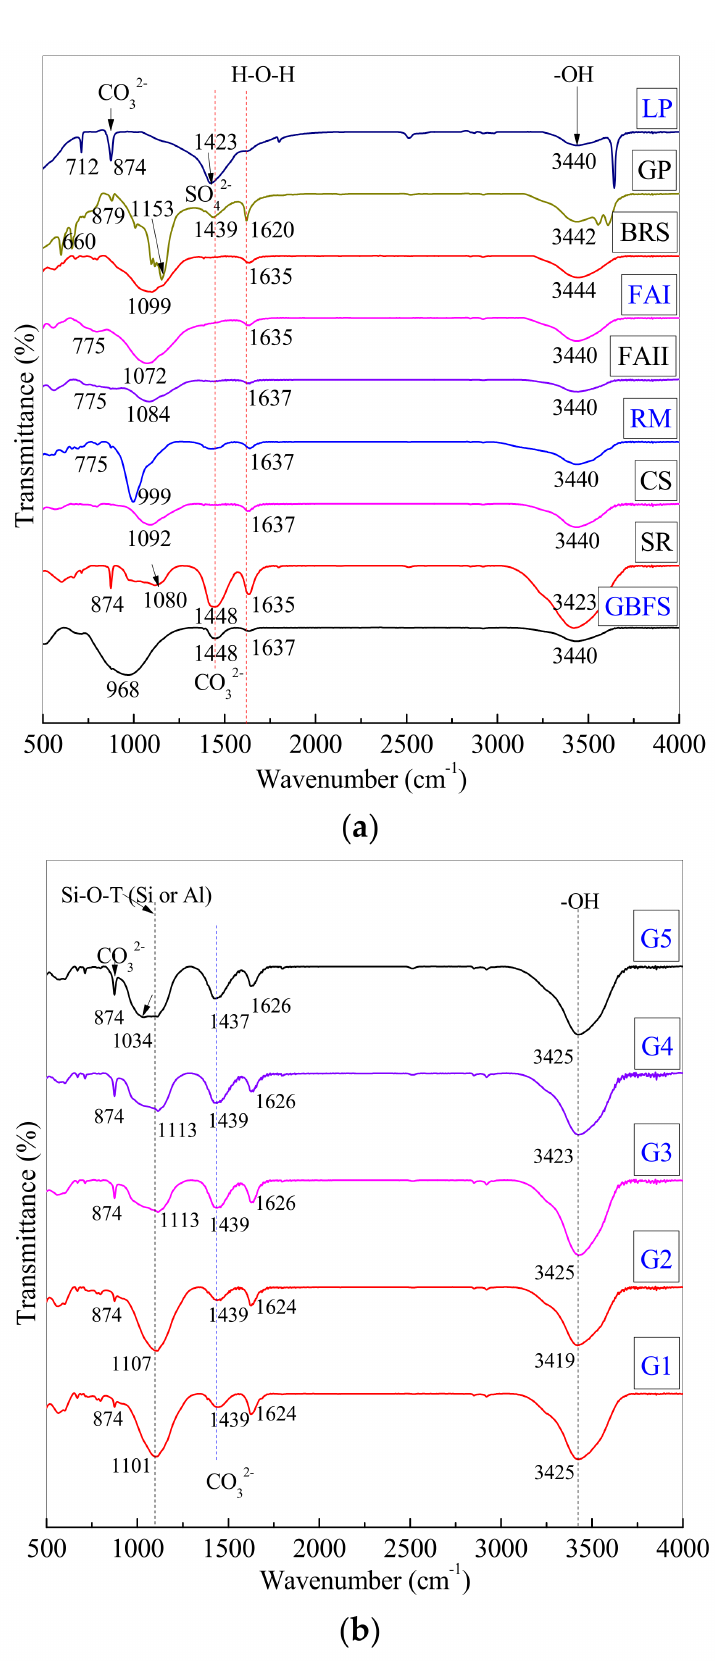
Figure 7. The FTIR spectra of ( a ) raw materials and ( b ) pastes G1, G2, G3, G4, and G5 at 90